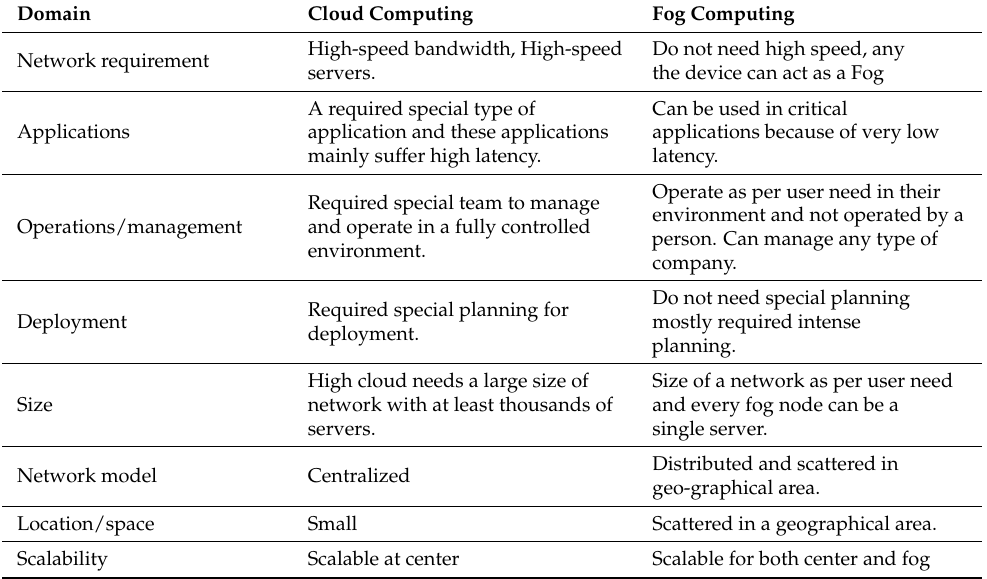
Table 2. Rule-based recommendations for